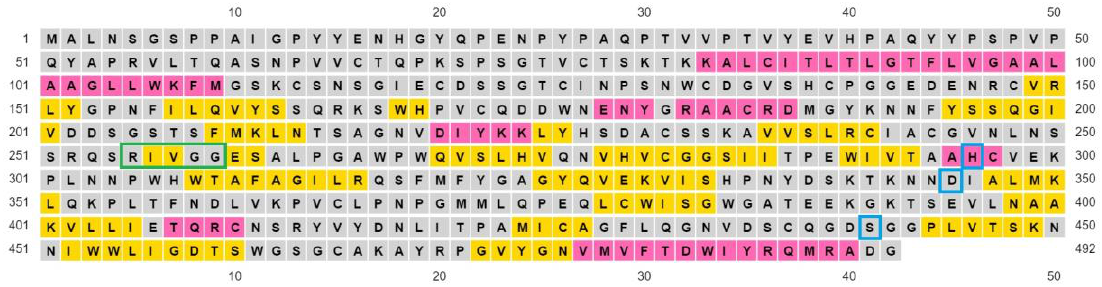
Figure 6. Amino acid sequence of TMPS2 showing α-helices coloured in pink, β-sheets coloured in yellow, loops coloured in grey, the catalytic triad residues are surrounded in cyan and the cleavage site is surrounded in green.